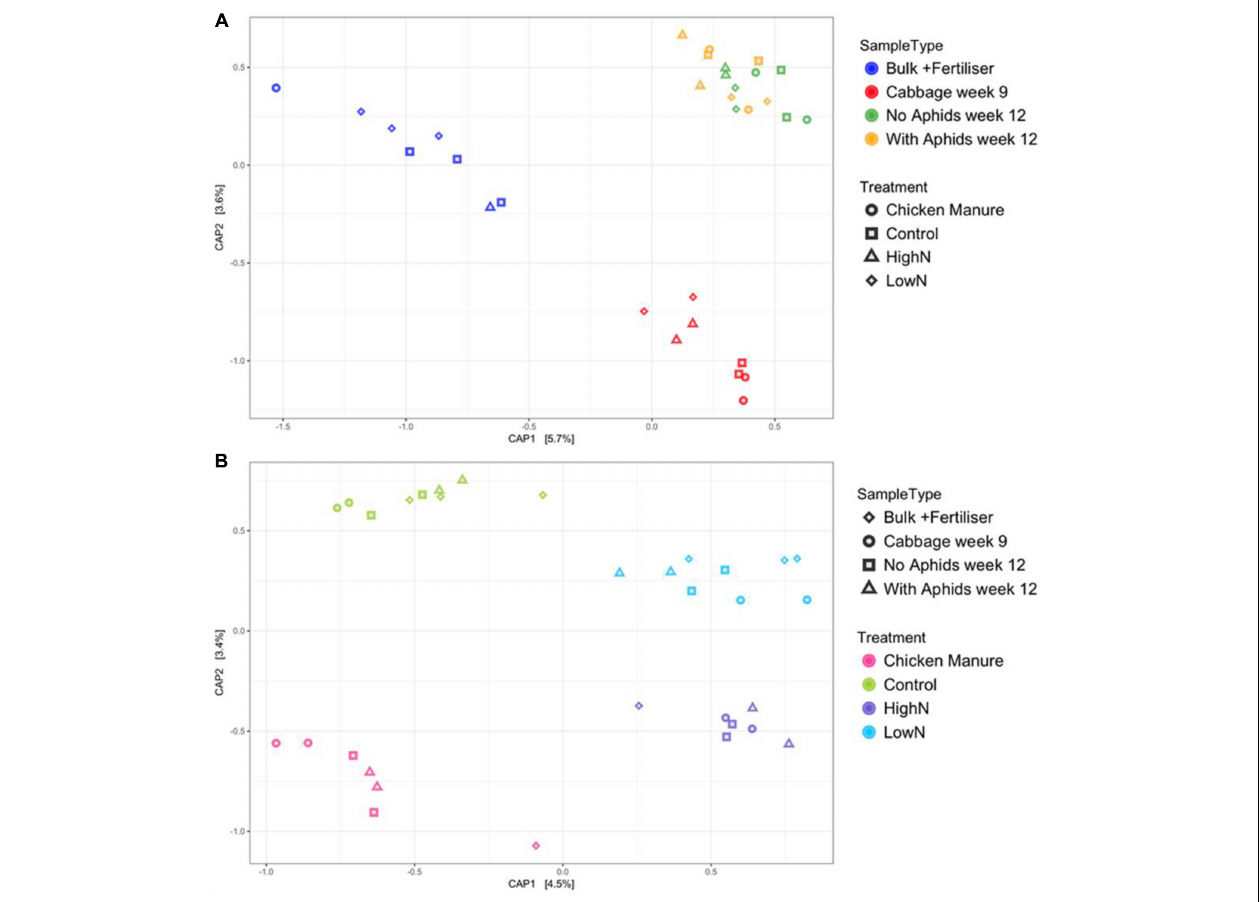
FIGURE 3 | Canonical analysis of principal coordinates (CAP) plots created using unweighted UniFrac measures grouped by (A) sample type and (B) fertilizer treatment. PERMANOVA with 9999 permutations: (A) Sample type: p = 0.0001, F 3 , 28 = 1.3008, SS = 0.3937; (B) Fertilizer treatment: p = 0.0088 , F 3 , 28 = 1.1458, SS =